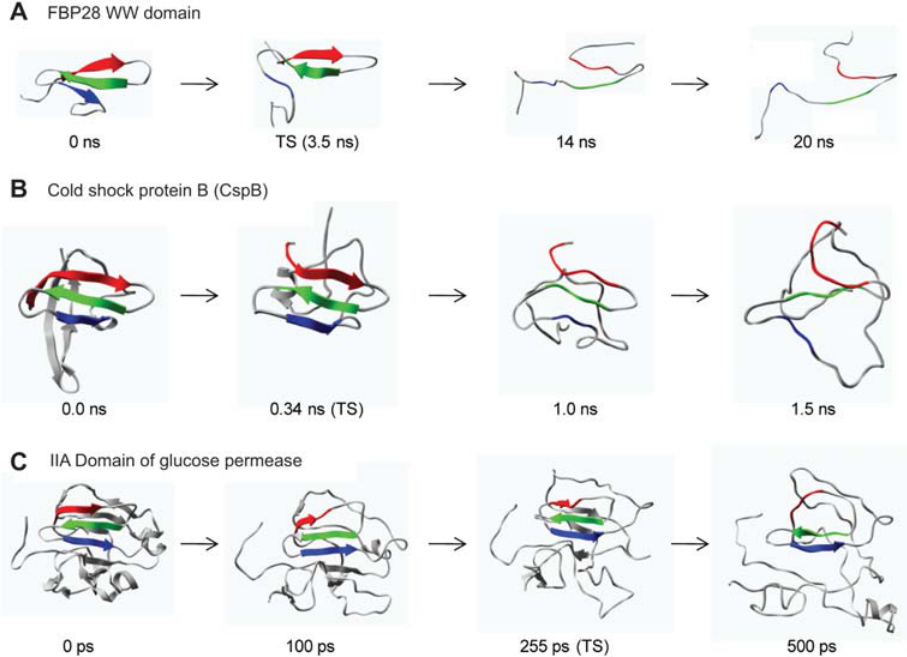
Figure 5 Unfolding of the double hairpin motif in different protein contexts. (A) Snapshots from a 348 K unfolding simulation of FBP28 WW domain with b 1 in red, b 2 in green and b 3 in blue. (B) Snapshots from a 498 K simulation of CspB with b 1 in red, b 2 in green and b 3 in blue. (C) Snapshots from a 498 K simulation of IIA domain with b 4 in red, b 5 in green and b 6 in